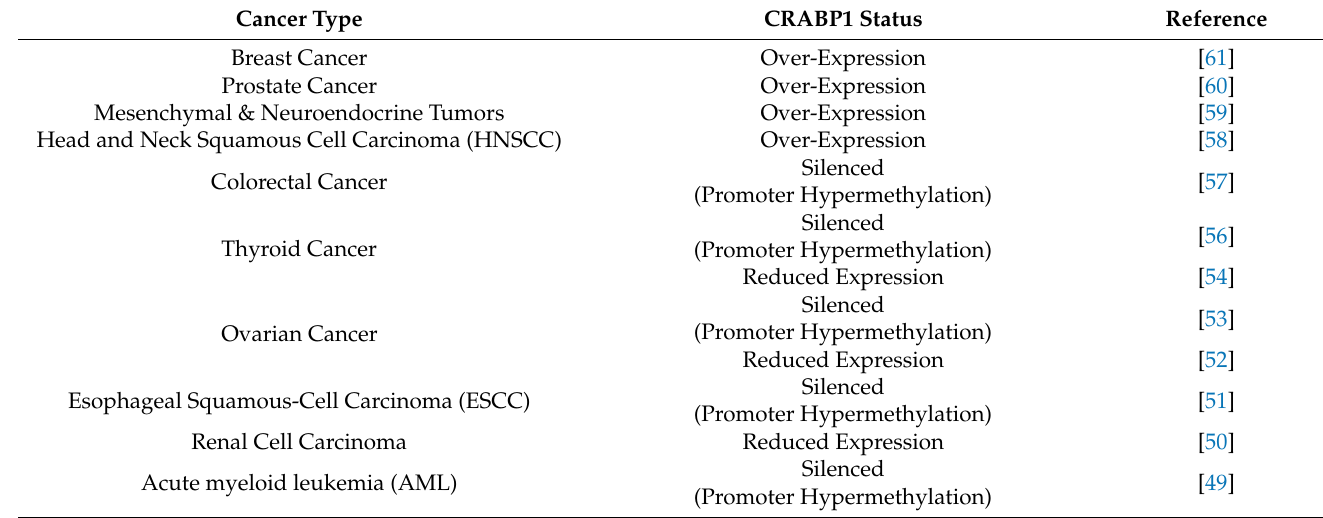
Table 1. Changes in CRABP1 detected in human